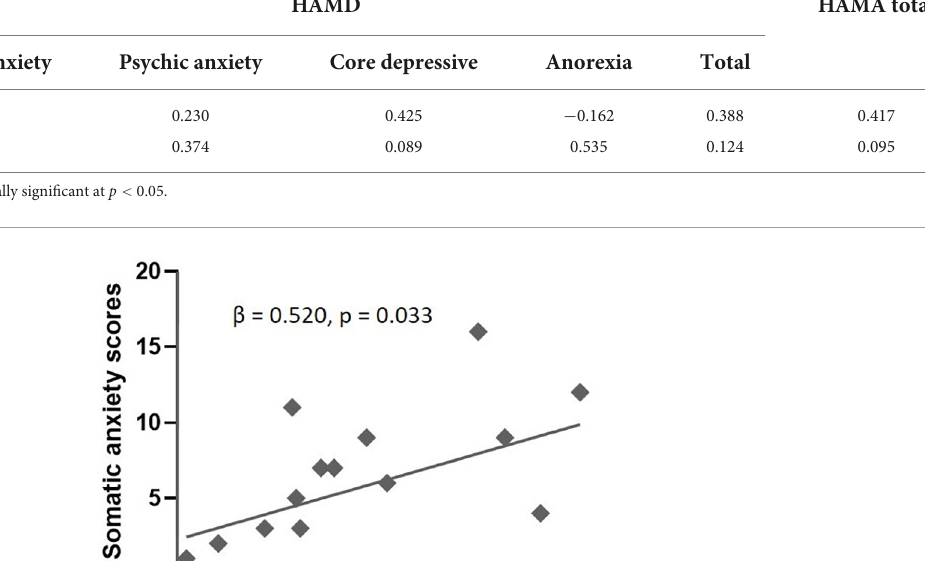
TABLE 2 Correlations between levels of leptin and clinical symptoms in MDD.